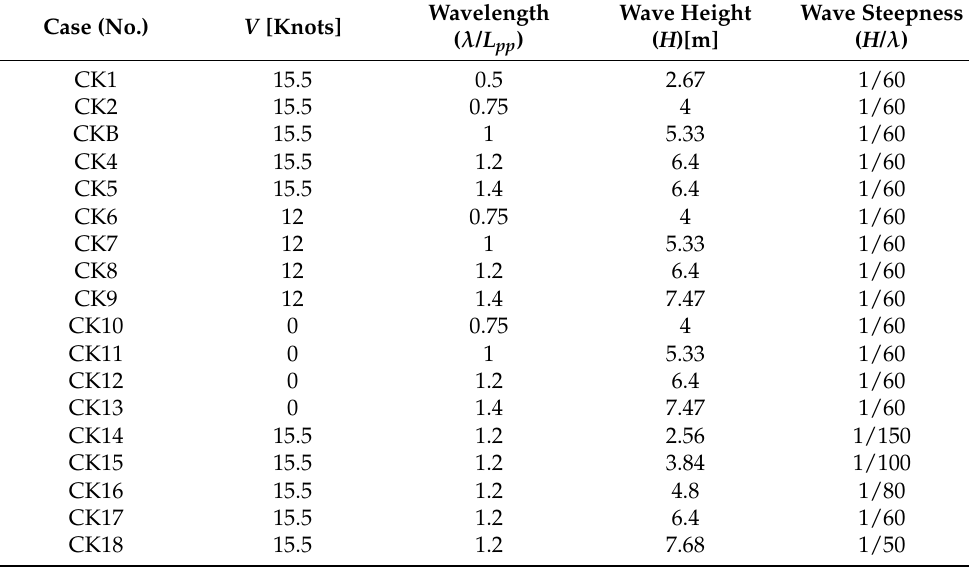
Figure 10. Time histories of heave and pitch motions in waves (Case CKB). ( a ) Heave; ( b ) Pitch. Table 4. Test Cases of